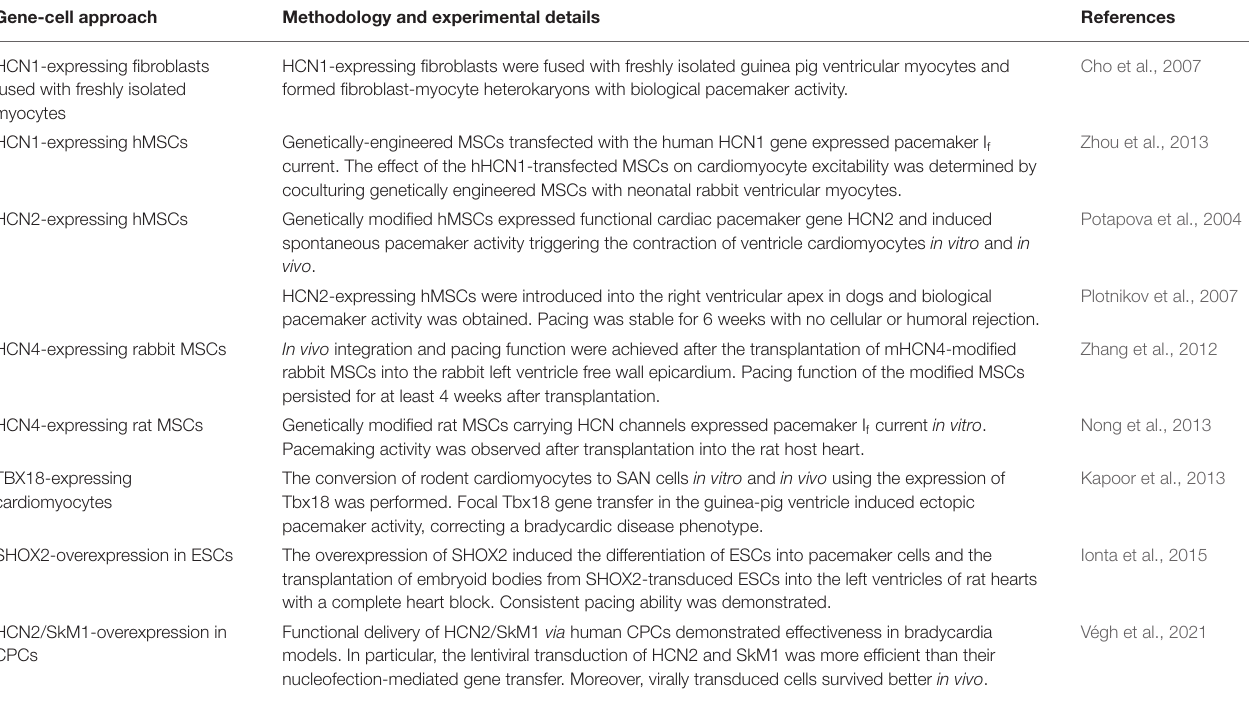
TABLE 4 | Combined gene-cell biopacemaking